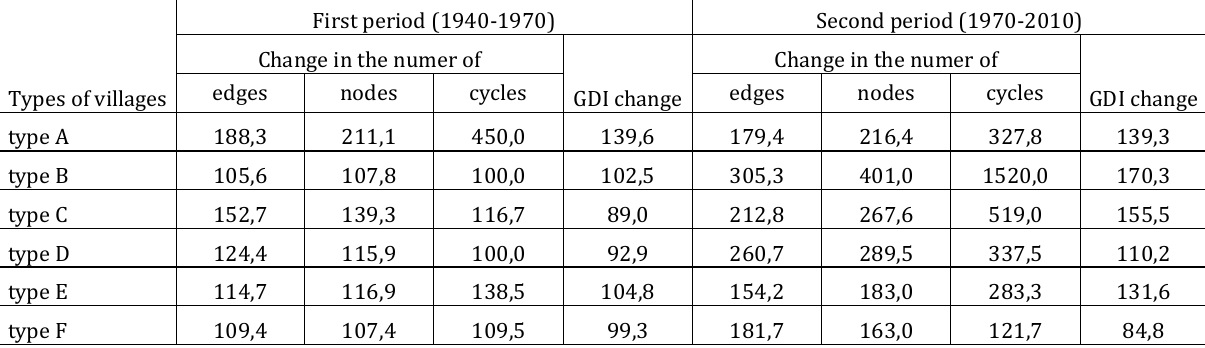
Table 2. The specificity of morphological transformations in villages located in the suburban area of Wrocław in the post-war period